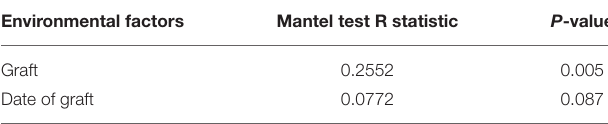
TABLE 3 | Mantel test of environmental factors in mice microbiome. Environmental